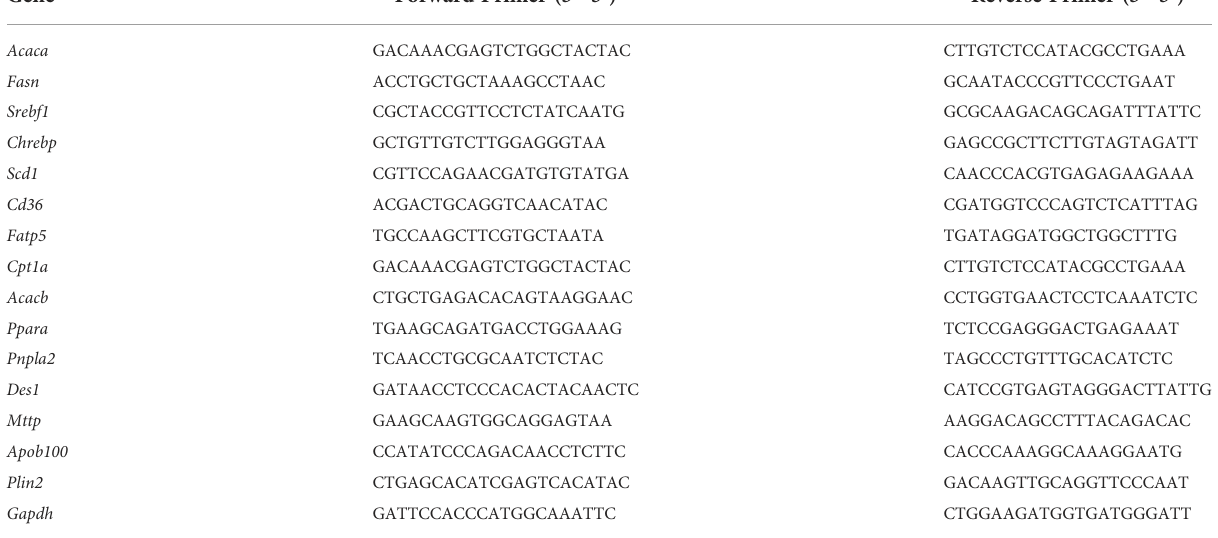
TABLE 2 Primer sequence of genes used for